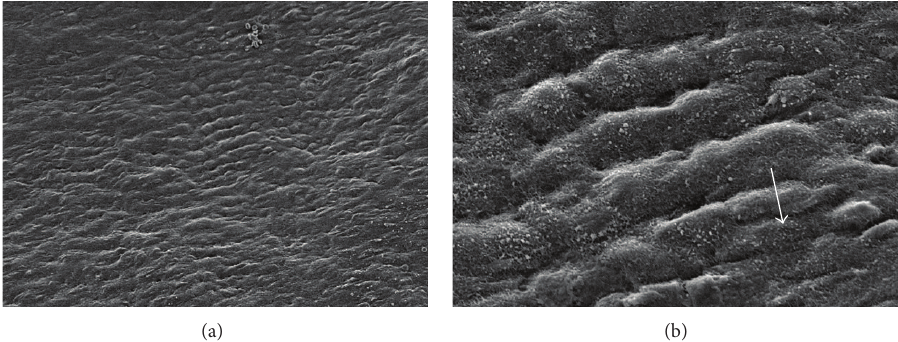
Figure 2: SEM showing mesothelial surface from control animals (group 1). Cells are aligned in rows with some elevation; microvilli are present but sparse (arrow): (a) original × 650; (b) original ×